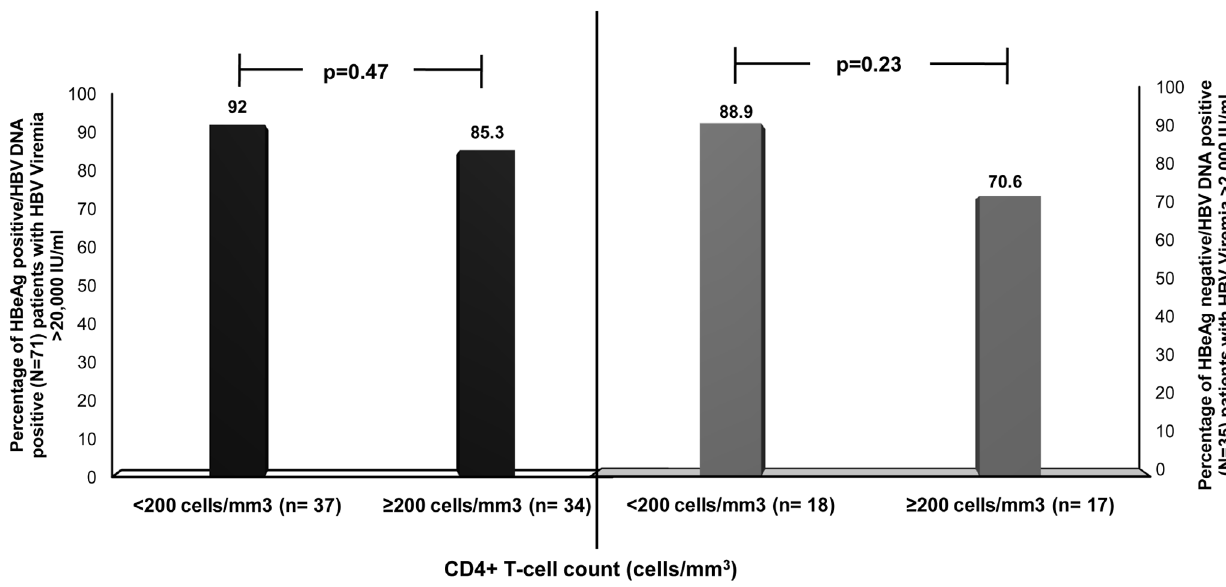
Figure 2. Frequency of subjects with HBV DNA $ 20,000 IU/ml (HBeAg + ) and $ 2,000 IU/ml (HBeAg 2 ) by CD4 + T-cell count. There was no significant difference in the percentage of HBeAg positive patients with HBV DNA $ 20,000 IU/ml between the two CD4 + T-cell count categories (p=0.47). This indicates the higher association of HBeAg positive subjects with greater HBV viremia, irrespective of CD4 + T-cell count. Similarly, for the HBeAg negative patients, no distinct variation was observed (p=0.23).